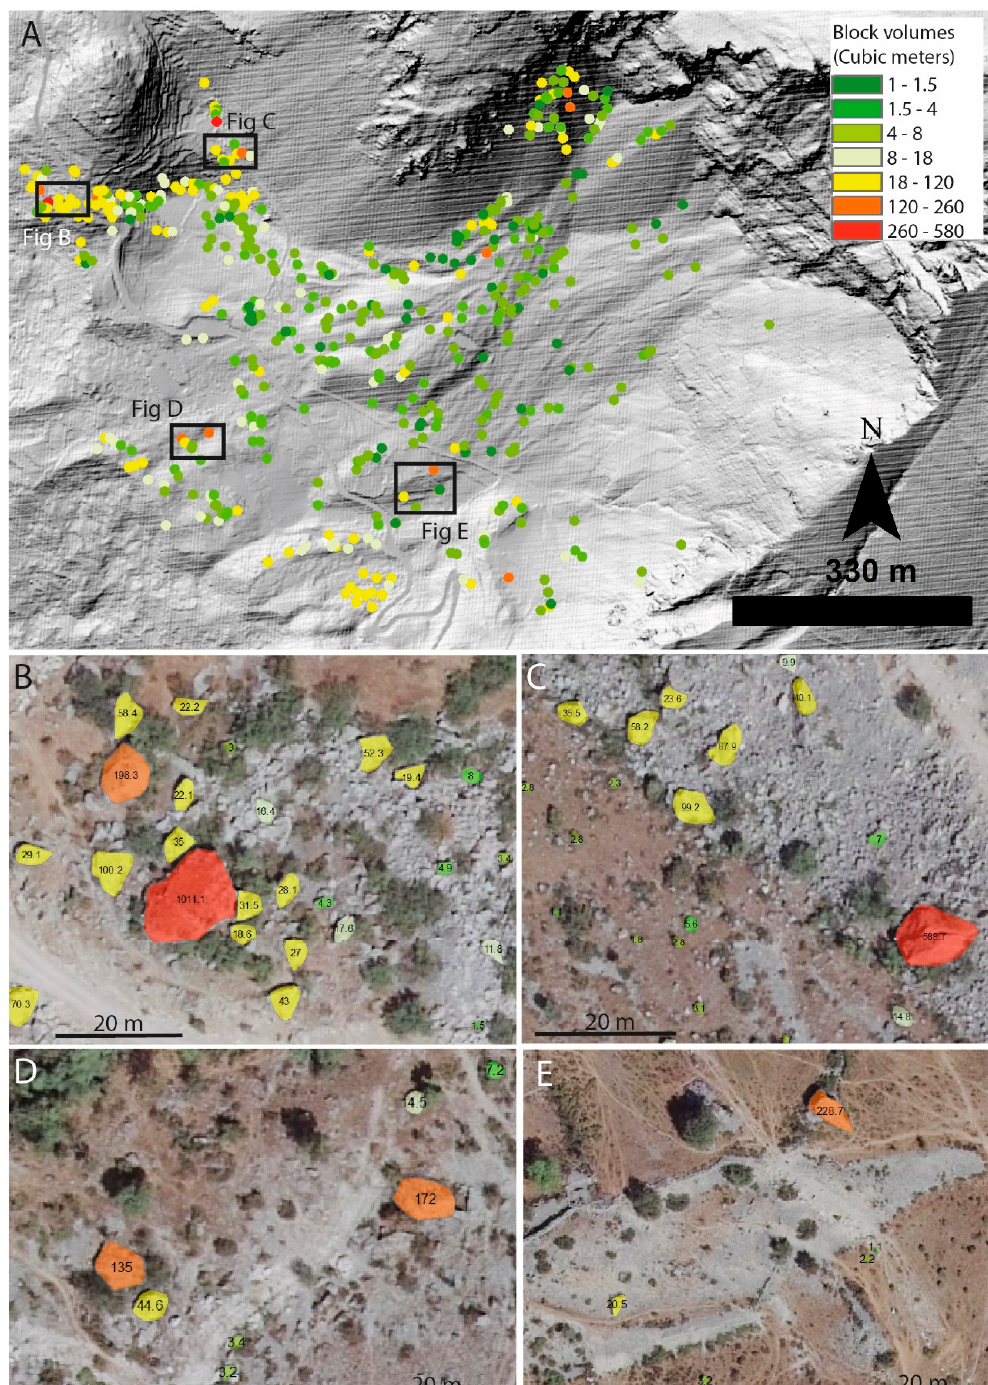
Figure 6. ( A ) Map of rock blocks associated with recent rockfall events and grouped per volume class. ( B–E ) Some examples of blocks identified in the study area (blocks are grouped per volume class using the same color scale of Figure 6A, and labels indicate volumes, m 3 ).